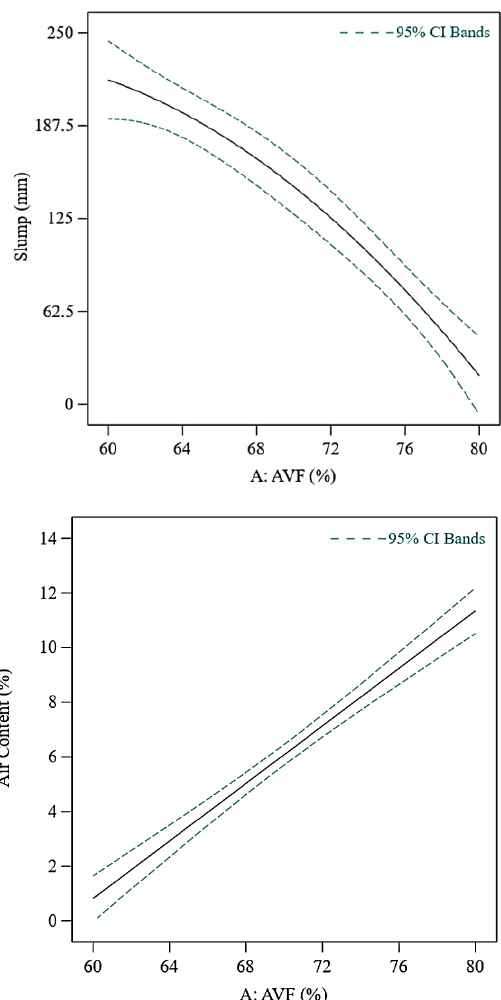
Figure 3. Effect of AVF on compressive strength, slump, AVPP, and air content.